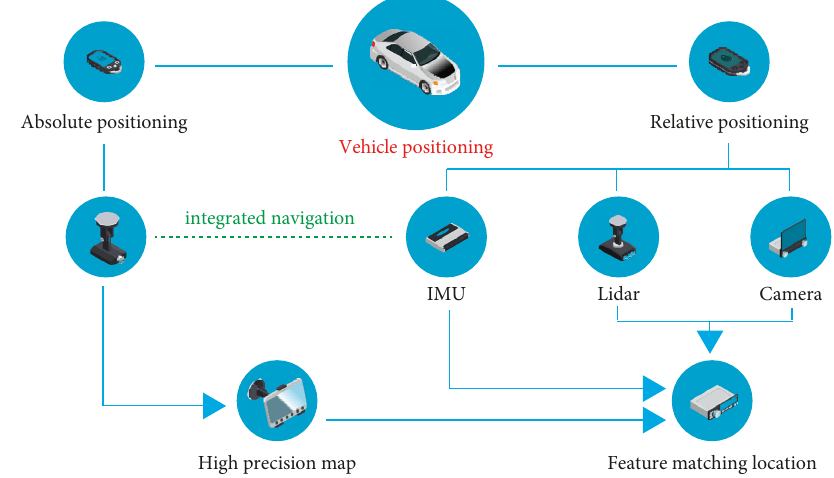
Figure 2: Driving detection with a multifeature fusion.